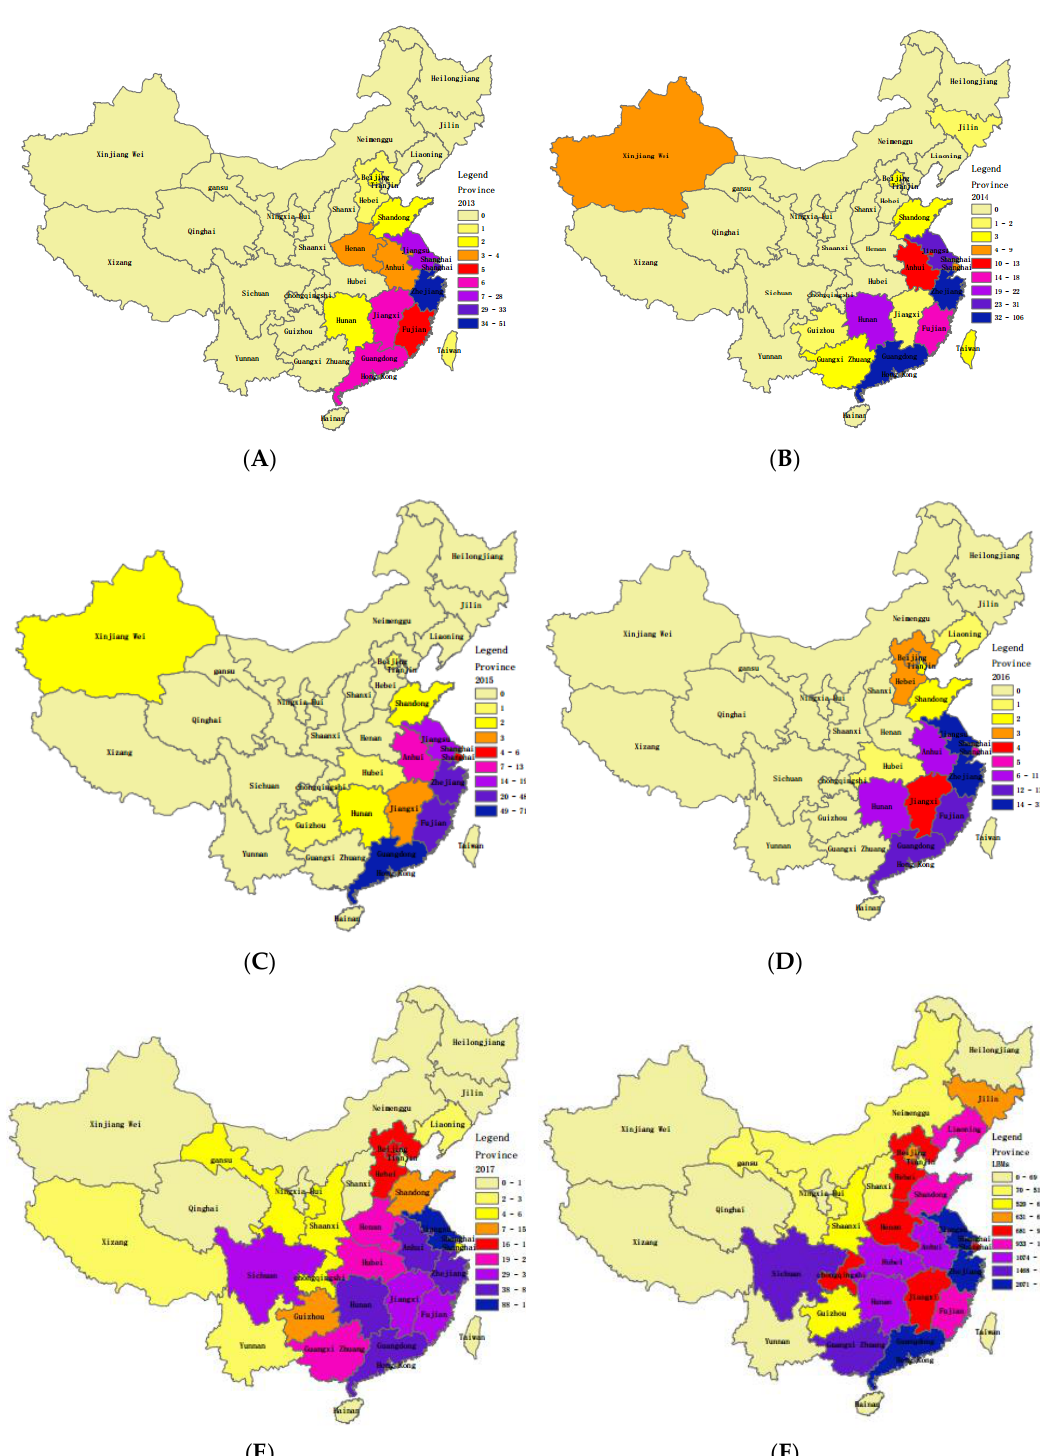
Figure 2. The map of reported human cases of A(H7N9) prevalence and the number of live poultry markets (LPMs) in China. ( A ) – ( E ) Distribution of cumulative numbers of A(H7N9) cases each year from 31 March 2013 to 13 May 2017 in mainland China (including 23 provinces, 4 municipalities, and 5 autonomous regions), Hong Kong, Macao and Taiwan. The number of cases at the region level is reflected by colored gradients, as shown in the legend. ( F ) Distribution of LPMs for regions in 2017. The map was plotted in ArcGIS 10.2 software (Esri, Redlands, CA, USA).